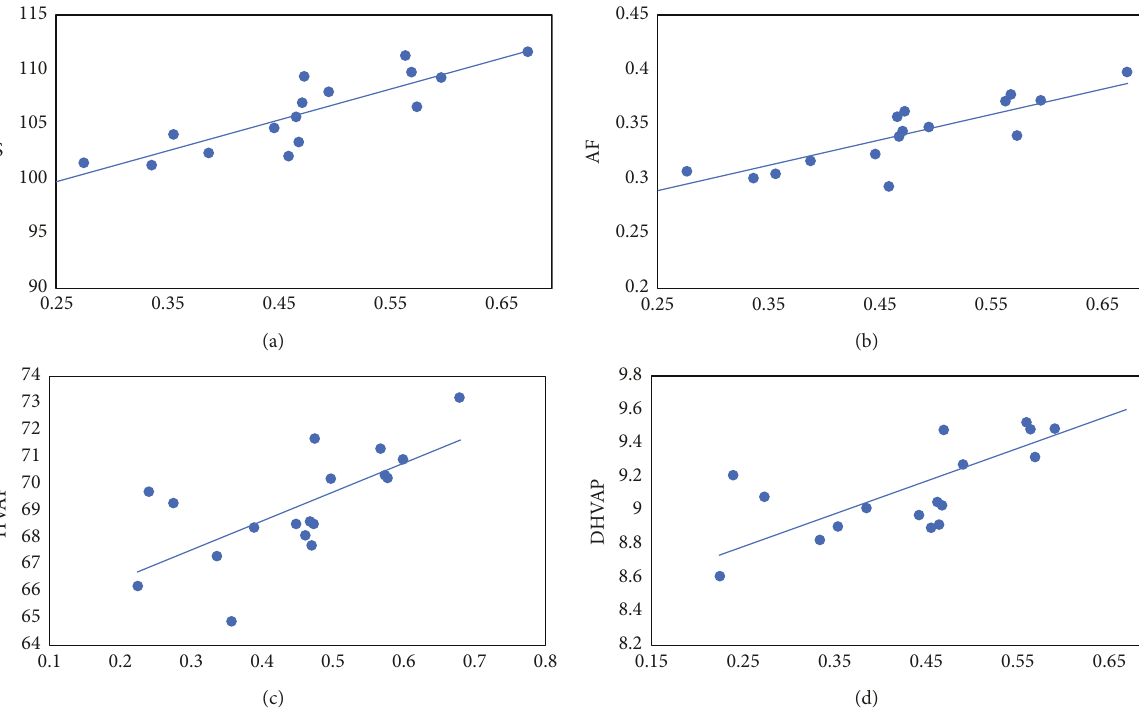
Figure 5: Correlation of NHG ( x -axis) and physical properties S, AF, HVAP, and DHVAP ( y